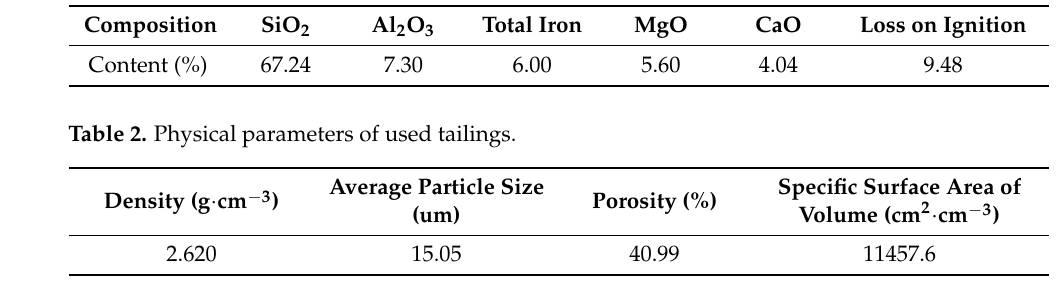
Table 1. Chemical composition of used tailings.